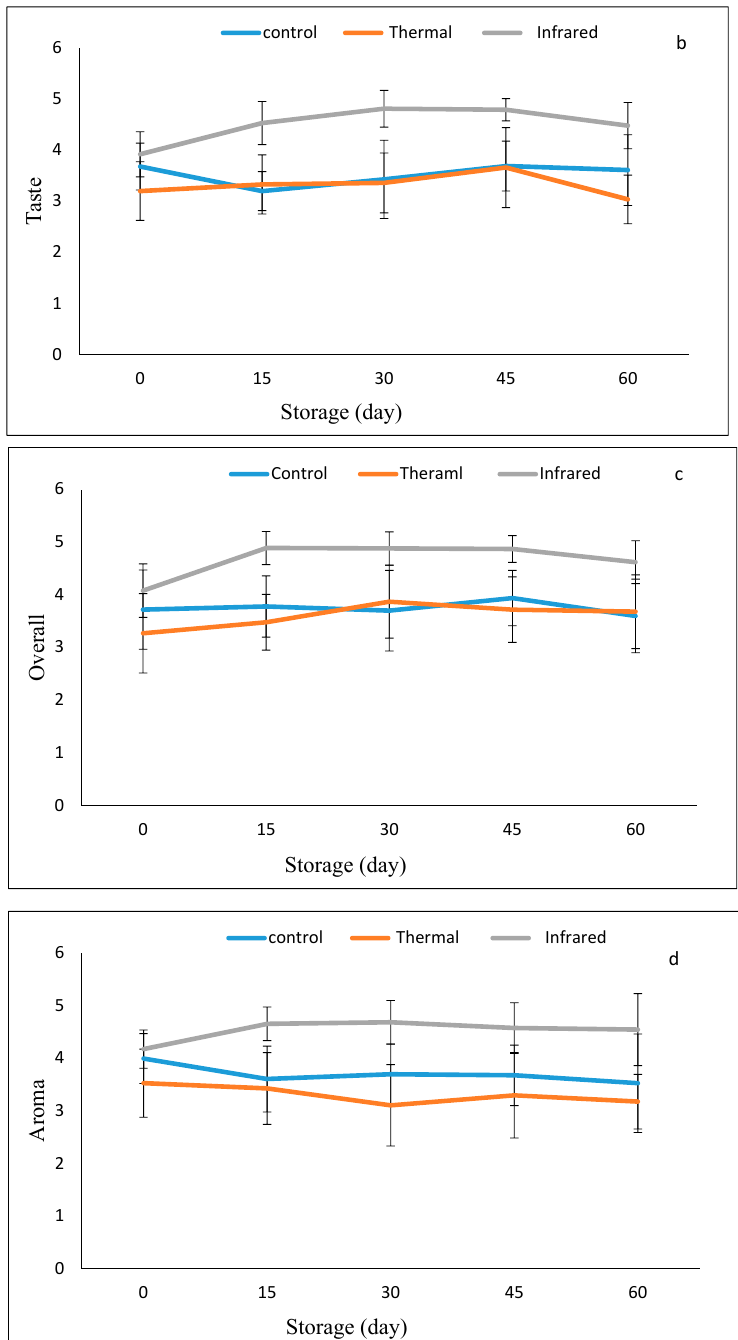
Figure 5. The effect of storage conditions on the ( a ) appearance attribute, ( b ), taste attribute, ( c ) overall acceptability attribute and, ( d ) aroma attribute of key lime juice samples stored at a temperature of 5 °C for a period of 60 days.